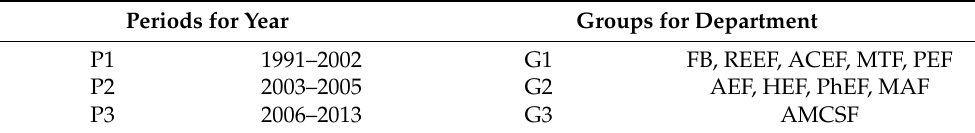
Table 3. Final partition by the year and the department obtained for BIC fitness function. Periods for